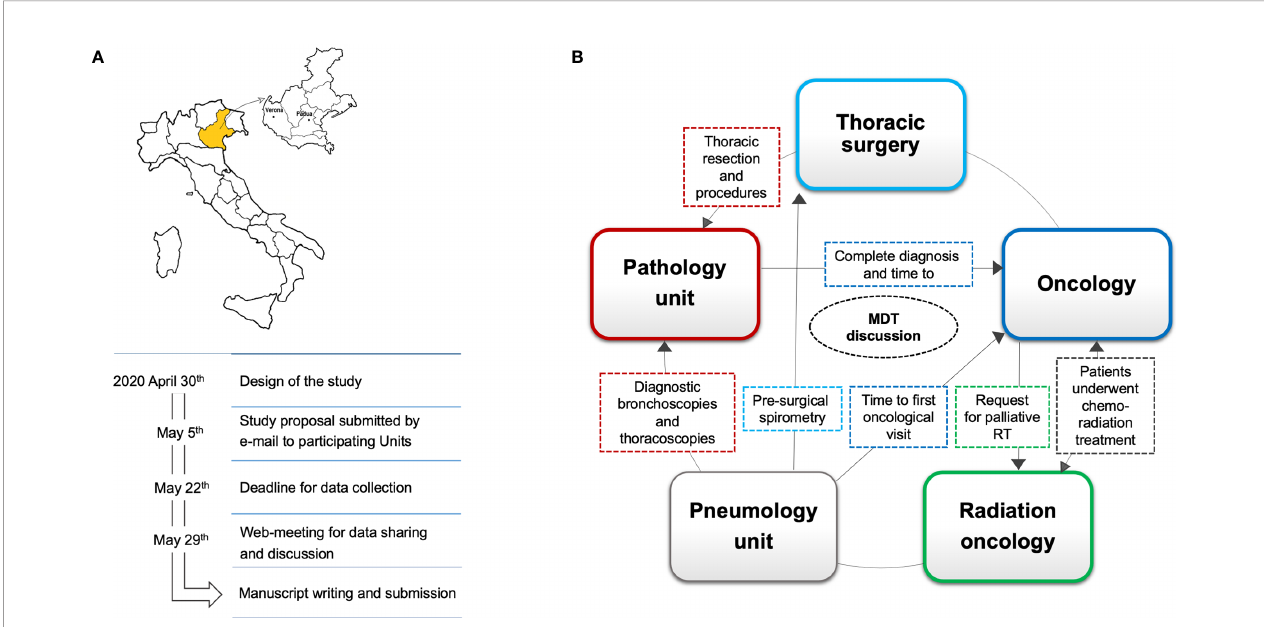
FIGURE 1 | Study design and data collection involving two Centers (Center 1 in Padua; Center 2 in Verona) in the Veneto region, marked here in yellow. The study ’ s main steps were pursued via telematics, from the study design to data collection and sharing results, in compliance with pandemic containment measures (A) . The impact of COVID-19 on lung cancer patient care was assessed through indicators (dashed lines), identi fi ed and selected from regional Integrated Care Pathways (ICPs) and from an expert panel on the basis of relevance to healthcare providers ’ workloads. The direction of the arrows depicts how these cancer specialists interact with each other in the context of ICPs, while the color of the indicator is the same as that of the healthcare provider whose activity is in fl uenced by (B) . MDT, multidisciplinary